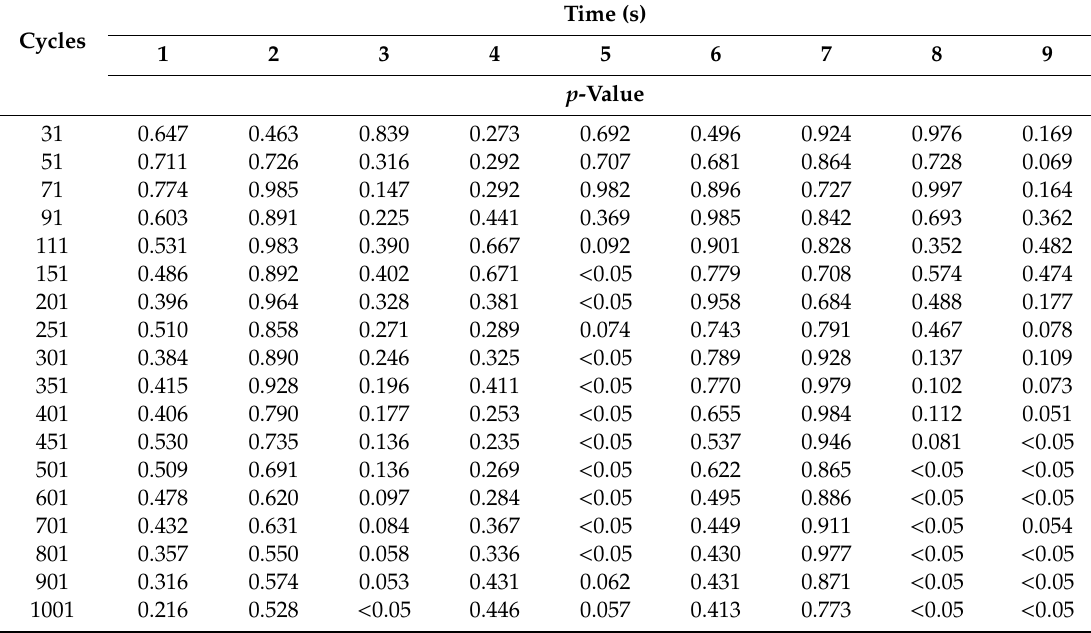
Table 4. Results of Two-sample t- test.